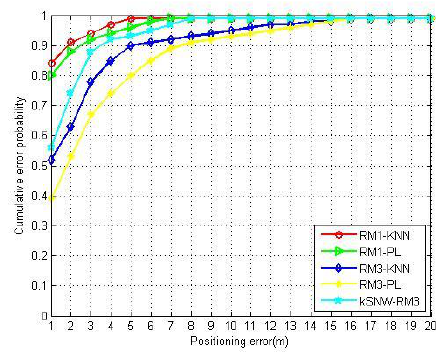
Figure 8. The positioning errors by different algorithms with different radio maps.